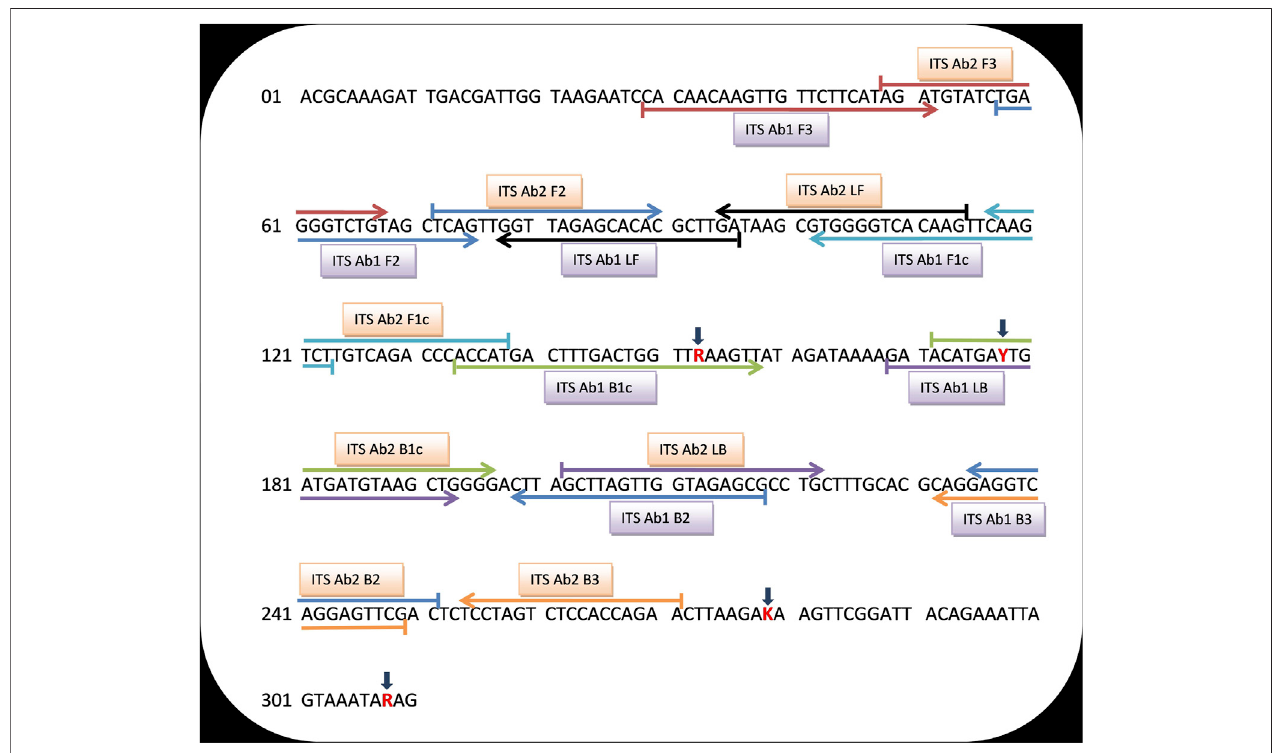
FIGURE3| AuniversalconsensussequenceoftheITS16S – 23SrRNAgenethatwasusedtodesigntheLAMPprimersfordetectionofsigni fi cantmembersofthe Acinetobacter calcoaceticus – baumannii (ACB) complex. Red color bases signify the mixed bases used in place of different bases present in A. baumannii , A. nosocomialis , and A. pittii . The sequences sites for ITS Ab1 and Ab2 LAMP primers are designated by upper and lower horizontal arrows, respectively. Right and left arrows indicate sense and reverse complementary sequences that were used.